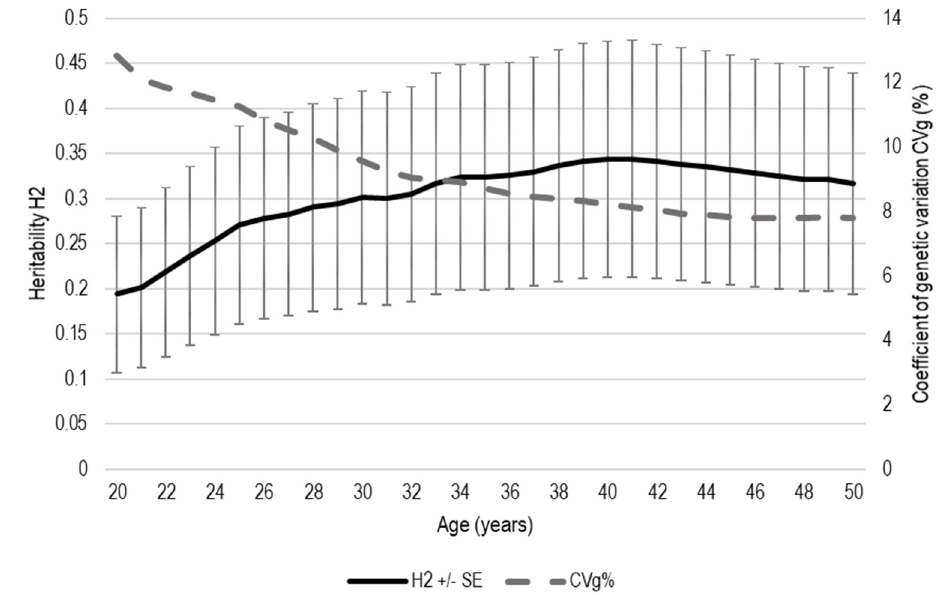
Figure 3. Dynamics of the estimated broad-sense heritability ( H 2 ) and genotypic coefficient of variation ( CV g ) during the studied period (age 20–50 years) of Norway spruce clones. The whiskers denote the standard error for H 2 .